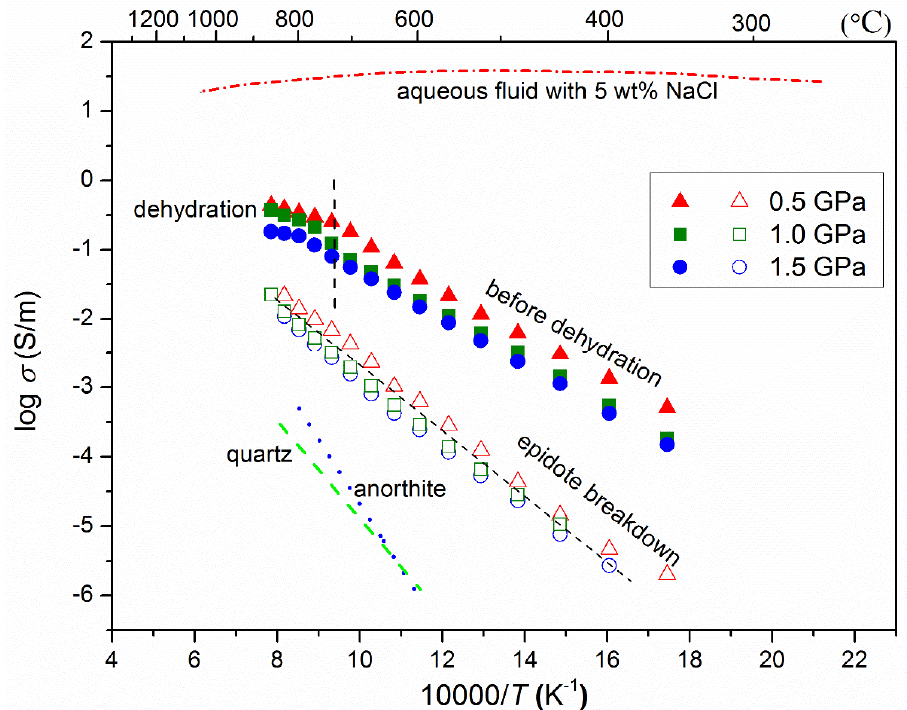
Figure 7. Pressure dependent electrical conductivity of hydrous epidote at the pressure ranges from 0.5 to 1.5 GPa and temperatures ranges from 573 to 1273 K. The dehydration reaction of hydrous epidote occurred at the critical temperature point of ~1073 K. The electrical conductivity of hydrous epidote is well reproducible before and after the occurrence of dehydration reaction at given pressure ranges from 0.5 to 1.5 GPa. Previously, acquired electrical conductivity results on the hot-pressed sintering polycrystalline quartz from Bagdassarov and Delépine (2004) [113], the synthetic polycrystalline anorthite from Hu et al. (2015) [60], as well as the pure aqueous fluid with the 5% of weight percentage of sodium chloride from Sinmyo and Keppler (2017) [114] are also compared in detail (reproduced with permission from the reference of Hu et al. [33]; published by the American Geophysical Union, 2017).